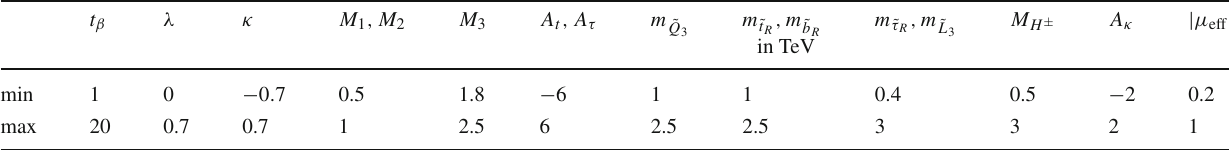
Table 1 Input parameters for the NMSSM scan. All parameters have been varied independently between the given minimum and maximum values